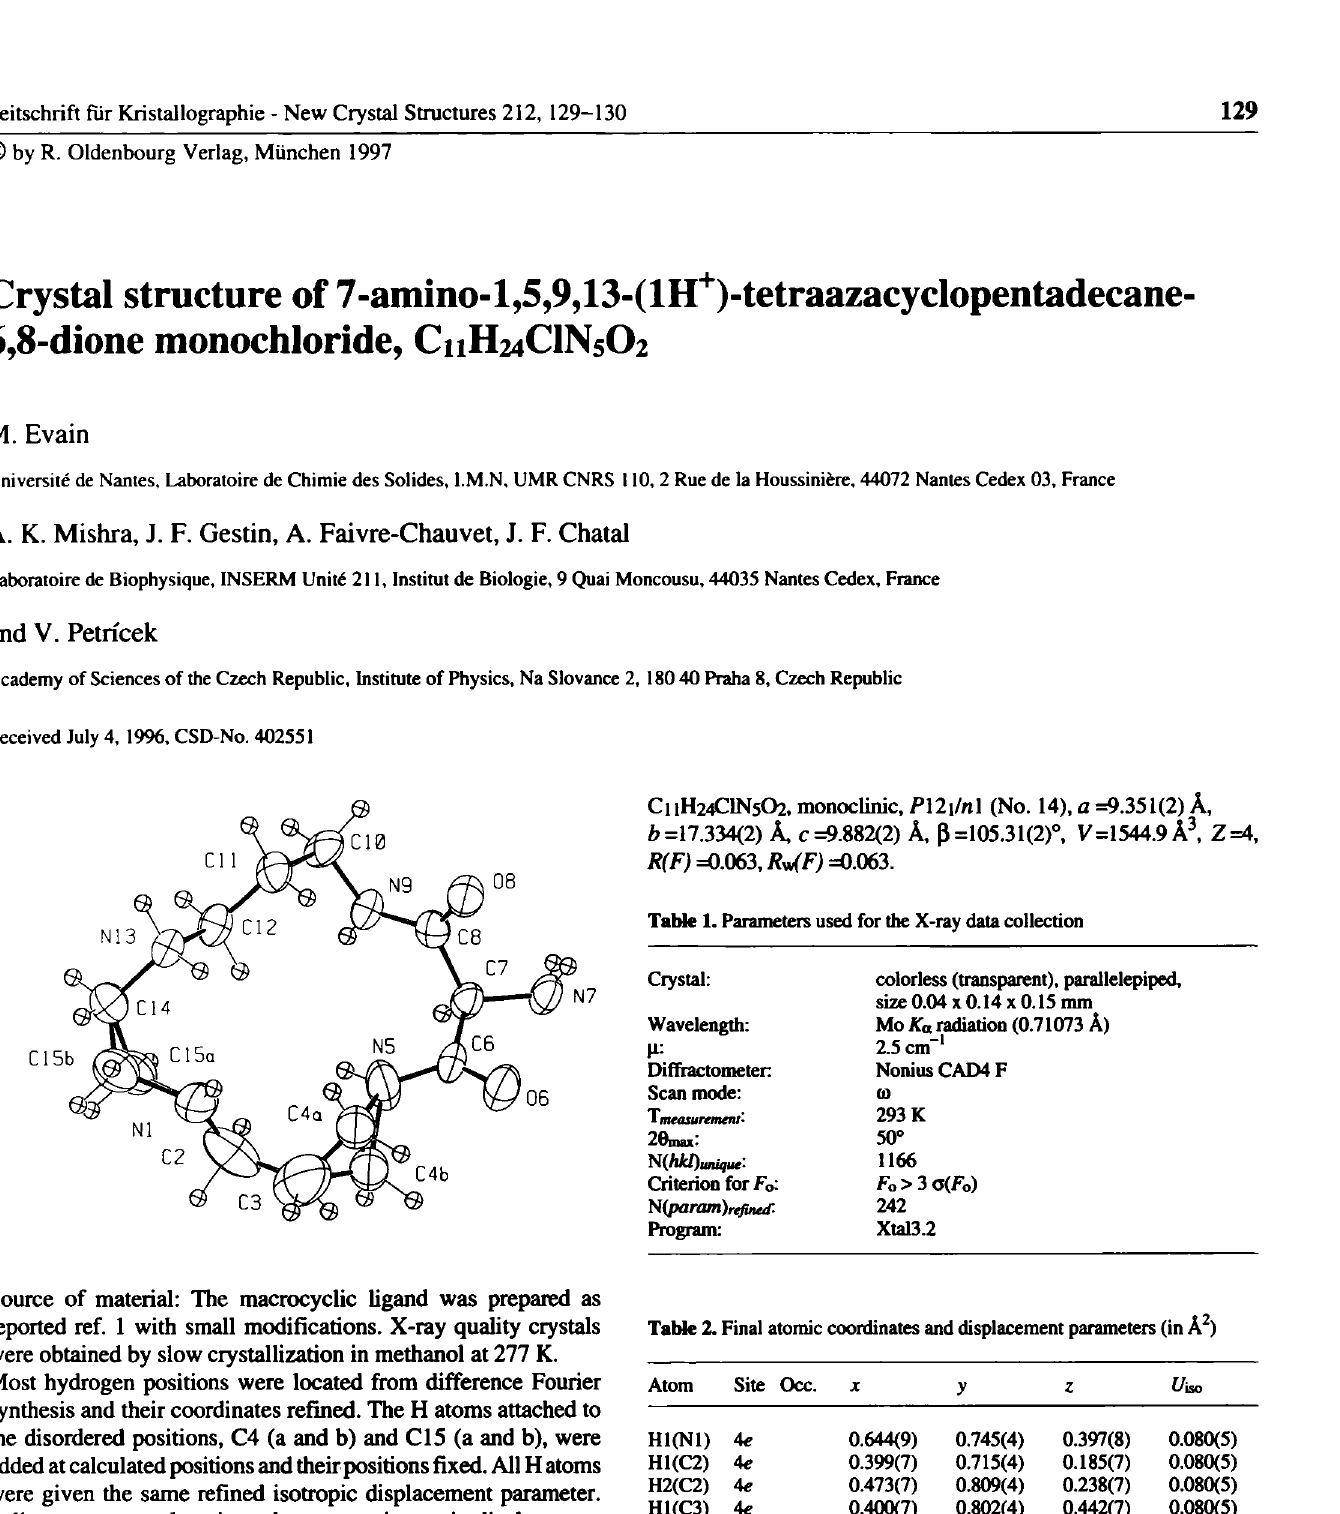
Table 2. Final atomic coordinates and displacement parameters (in Â 2